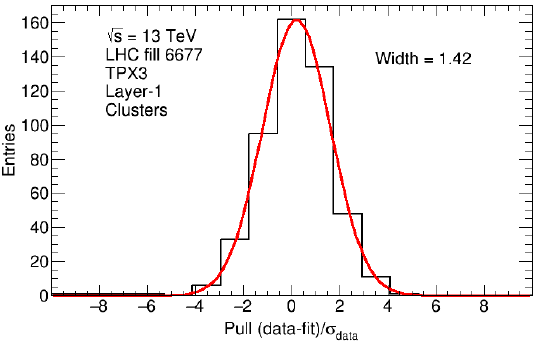
Figure 64. Pull distribution defined as (data-fit)/ σ data where σ data is the uncertainty from the cluster statistics. The data shown in Figure 63 are used (LHC fill 6677). Taken from Ref.